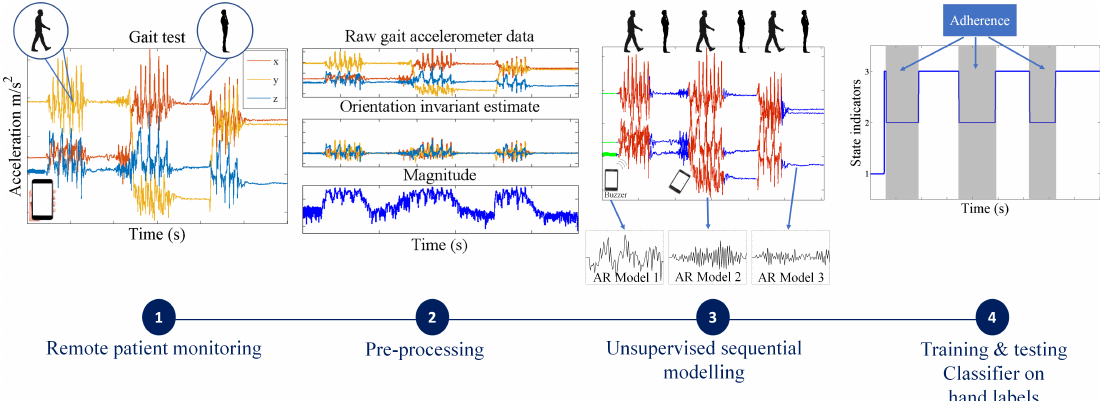
Figure 1. Overview of the proposed algorithmic framework for data quality control of sensor data for behavioral clinimetric testing. The first stage (starting from the left) involves collecting sensor data outside the lab. The second stage consists of removing confounding factors from the data such as the effect of the orientation of the device. The third stage involves unsupervised segmentation of the data into intervals in which the user performs similar activities. In the final stage, a simple, interpretable classifier is trained to predict which intervals are associated with adherence to, and which with violations of, the test